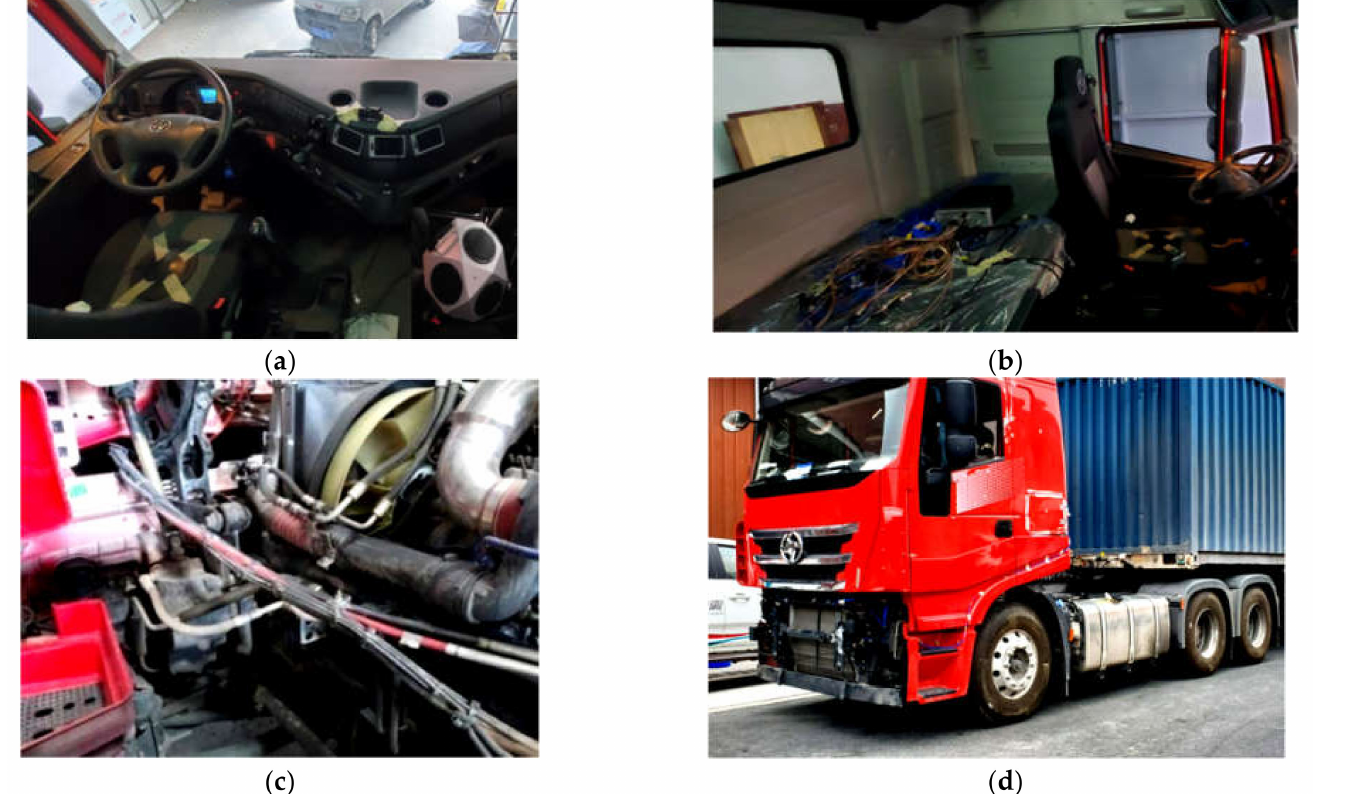
Figure 12. Observation points in the cab and engine compartment. ( a ) Volume sound source of internal sound field; ( b ) Cockpit test; ( c ) Engine room test; ( d ) Vehicle measuring point